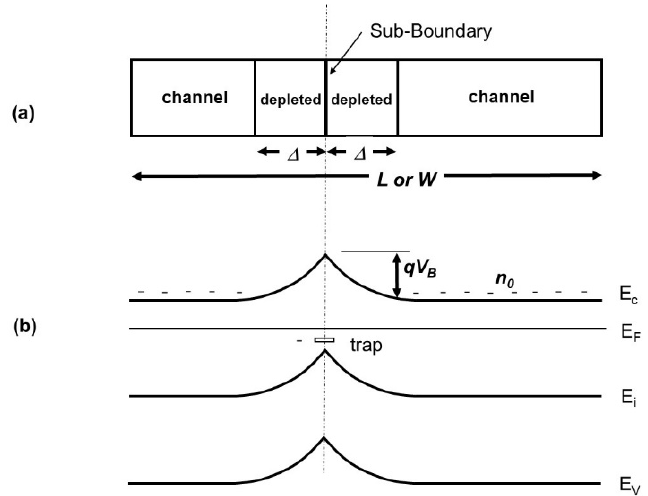
Figure 17. Theoretical model of ( a ) structure and ( b ) band diagram of the effect of sub-Bs. ∆ is the width of the depleted region at each side of sub-B induced by the charged sub-B trap states. qV B is the barrier height of free carriers in the sub-B.